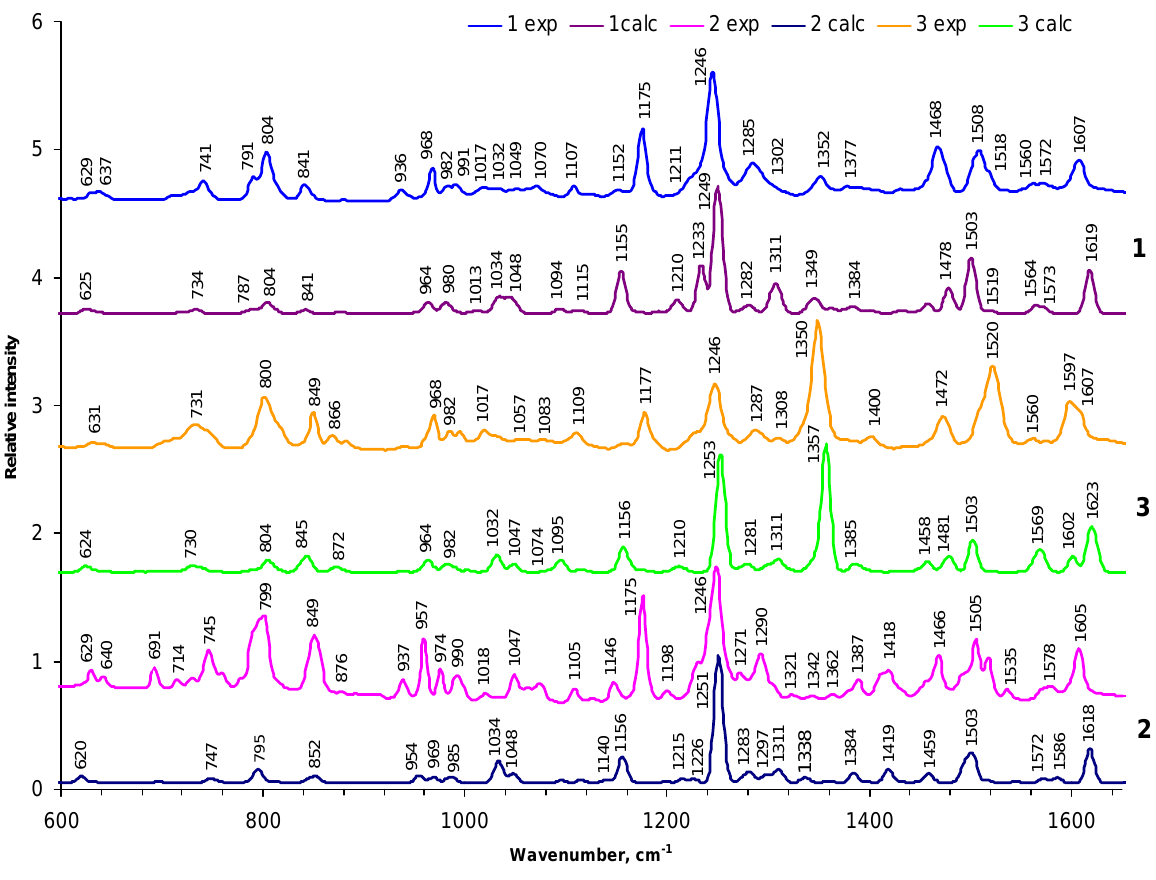
Figure 4. A comparison of the experimental and calculated IR spectra of the investigated tetra- and di-phenyl porphyrins (compounds 1–3